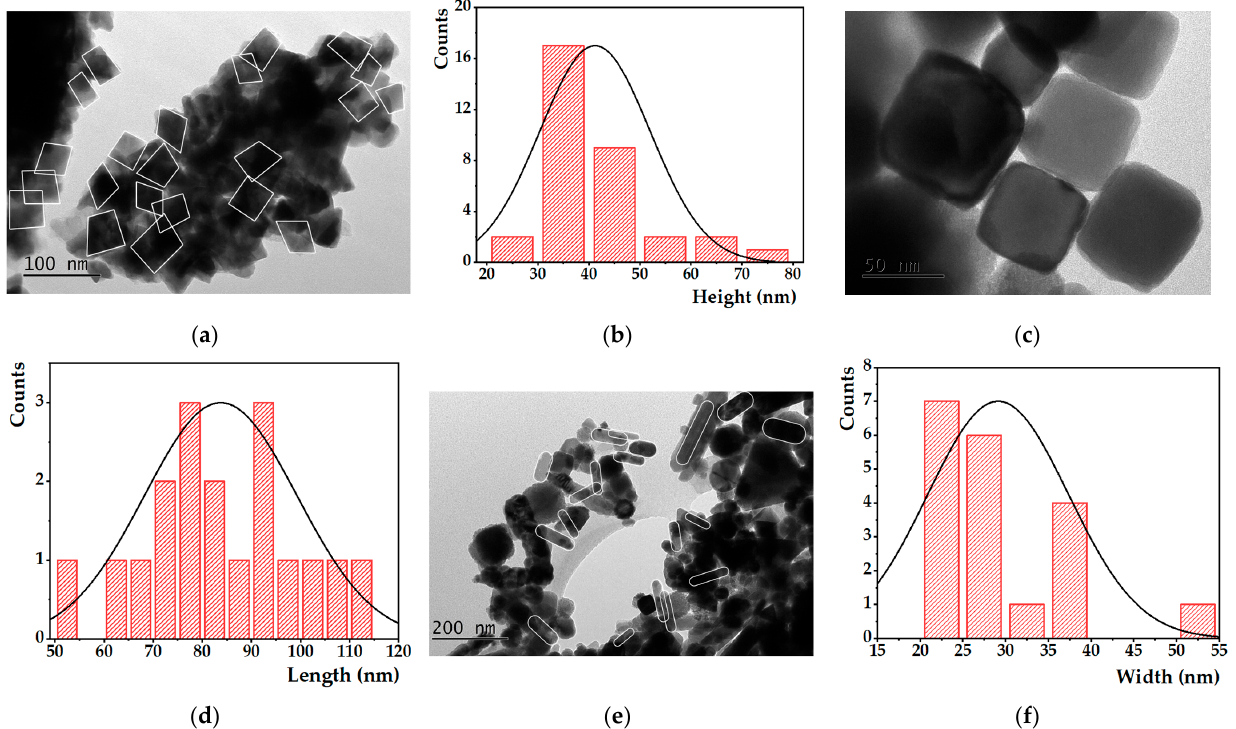
Figure 3. TEM images and size histograms fitted to a Gaussian distribution of non-calcined ( a – c ) and calcined ( d – f ) Mg 0.75 Ca 0.25 Fe 2 O 4 nanoparticles, at different magnifications.